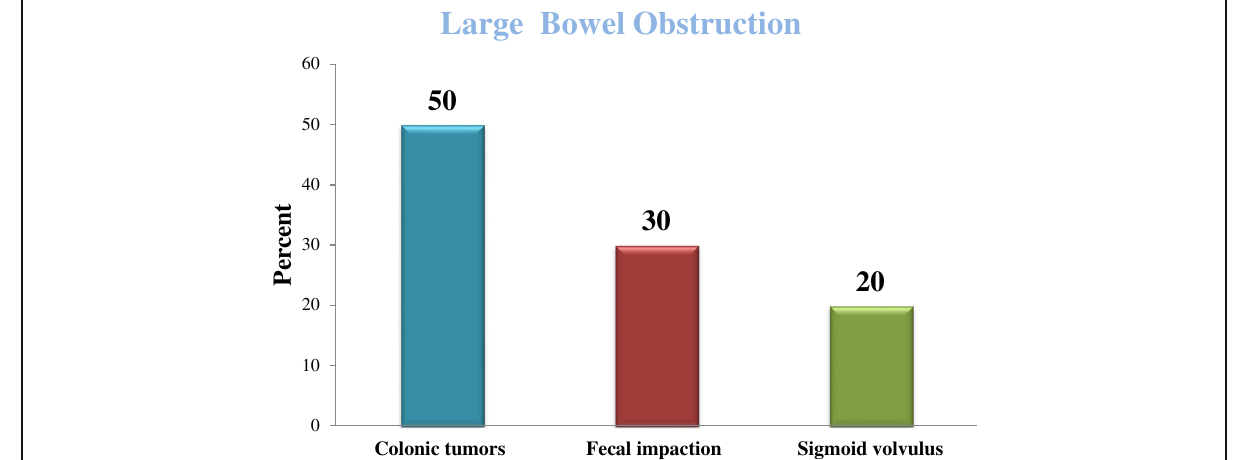
Fig. 4 Distribution of patients according to the causes of large bowel